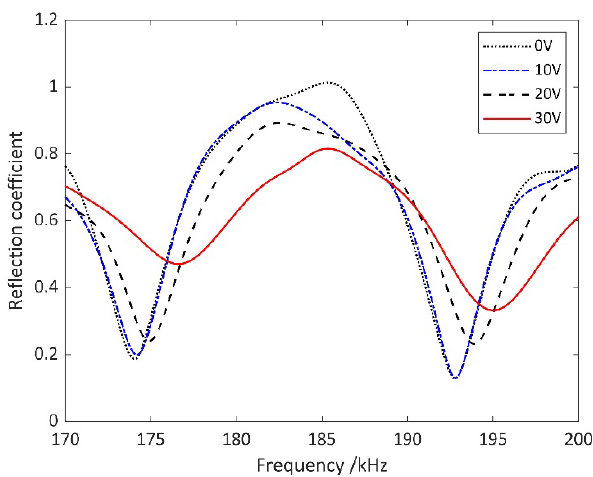
Figure 10. The reflected signal spectrum under different electrolytic voltages measured experimentally.